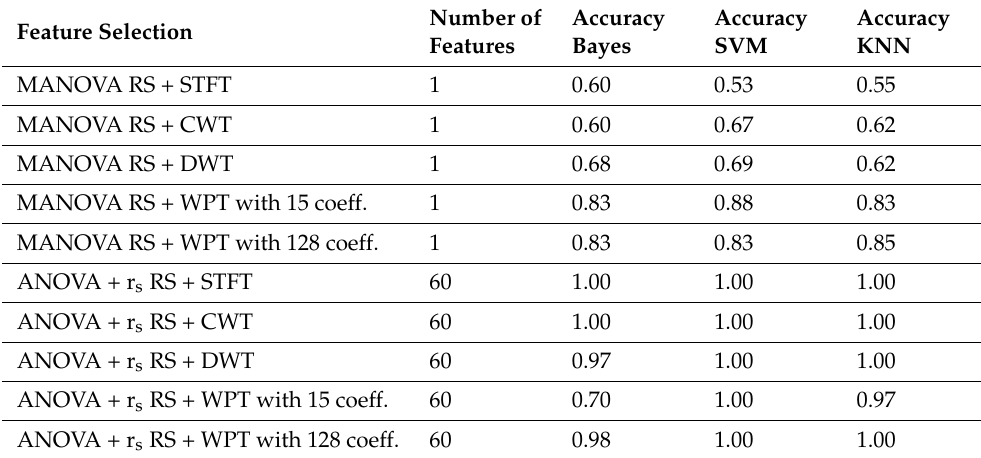
Table 6. Classification model evaluations for tool tumbling classification.